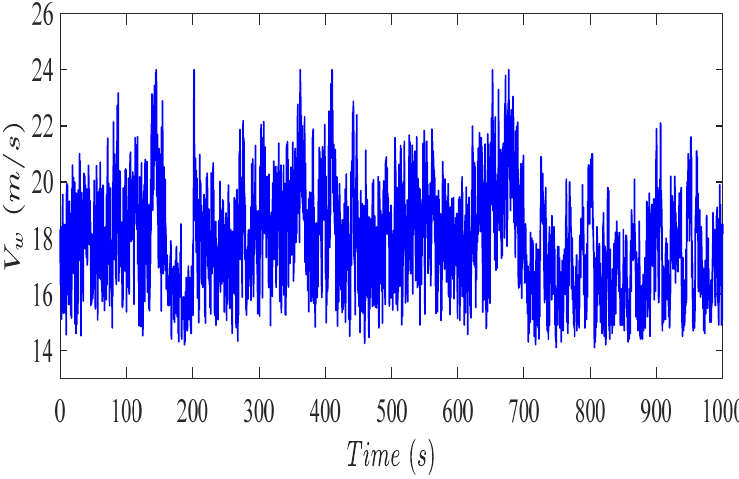
Figure 3. Free wind speed profile.